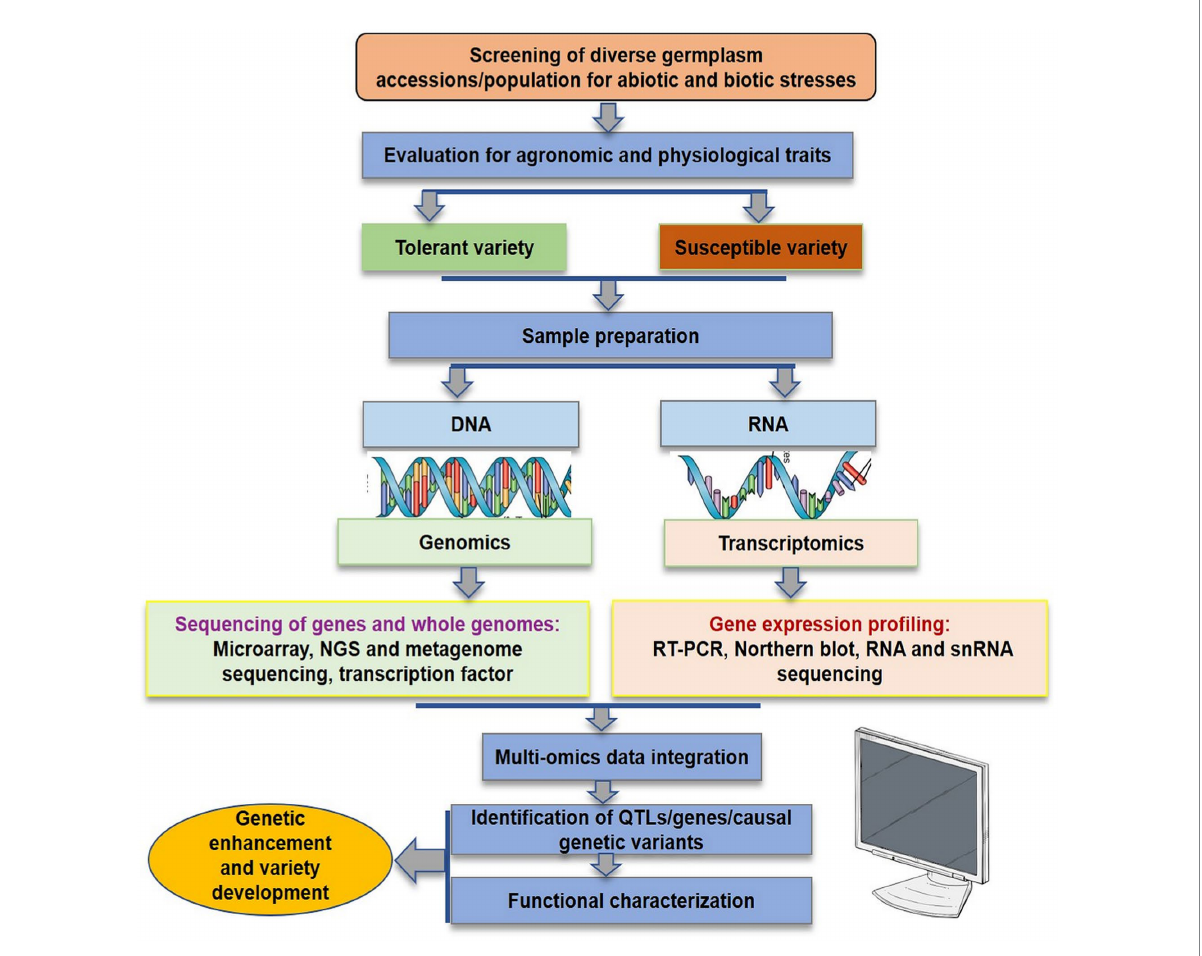
FIGURE 3 Genomics enabled strategies for flax improvement in response to adverse climatic conditions and pathogenic